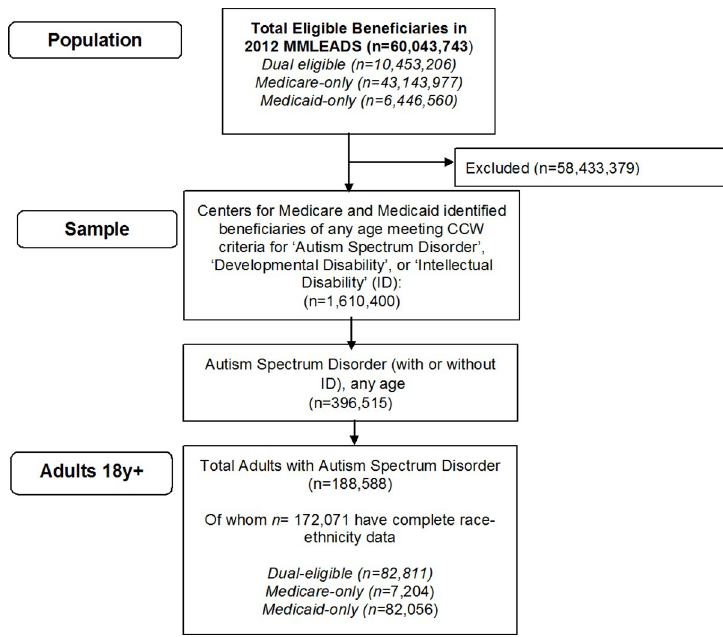
Fig 1. Identification of 2012 MMLEADSv2 analytic sample of adults with autism spectrum